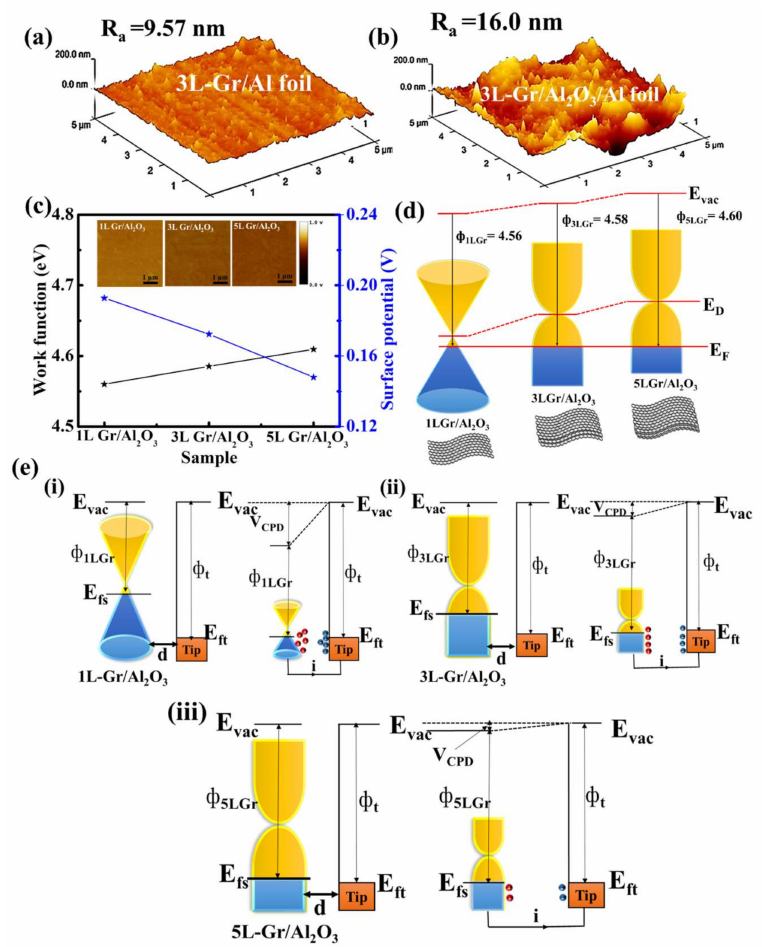
Figure 4. 3D AFM images of ( a ) 3L-Gr/Al-foil/PET substrate and ( b ) 3L-Gr/Al 2 O 3 /Al-foil/PET substrate. ( c ) Work function measurements of 1L-, 3L- and 5L-Gr on the Al 2 O 3 /Al-foil substrate by KPFM. Inset showing the surface potential of graphene layers (1L, 3L and 5L) over Al 2 O 3 . Schematic illustration of ( d ) energy band diagrams for 1L-Gr, 3L-Gr and 5L-Gr over Al 2 O 3 . ( e ) Electronic energy levels of graphene samples and AFM tip without and with electrical contact for three cases: ( i ) tip and the 1L-Gr over Al 2 O 3 /Al-foil/PET, ( ii ) tip and the 3L-Gr over Al 2 O 3 /Al-foil/PET and ( iii ) tip and the 5L-Gr over Al 2 O 3 /Al-foil/PET. E vac is the vacuum energy level. E fs and E ft are Fermi energy levels of the graphene sample and tip, respectively. V CPD is the contact potential difference, and Φ φ t are work functions of the graphene layer (n = 1, 3 and 5) and tip, nGr and